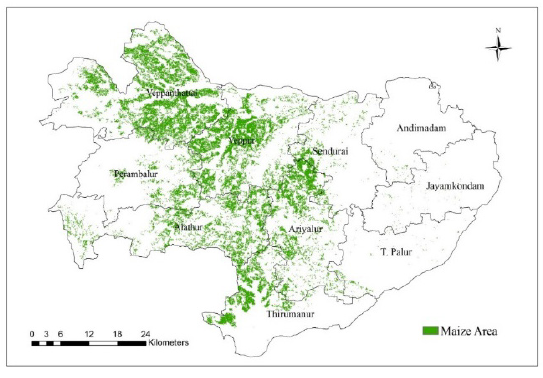
Figure 2. Maize area map